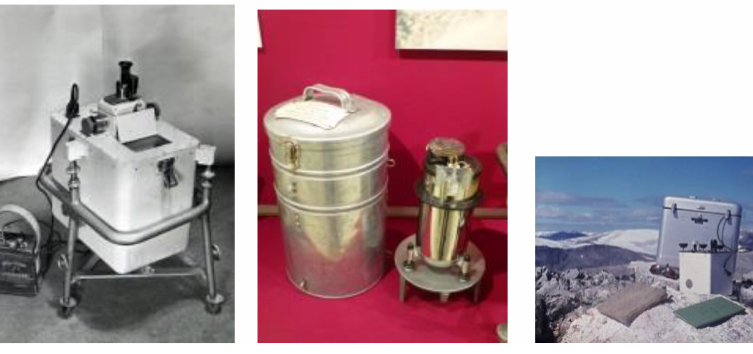
Figure 5. Relative gravimeters used in Norway: Nørgaard (left), Worden (center), and LaCoste & Romberg (right)